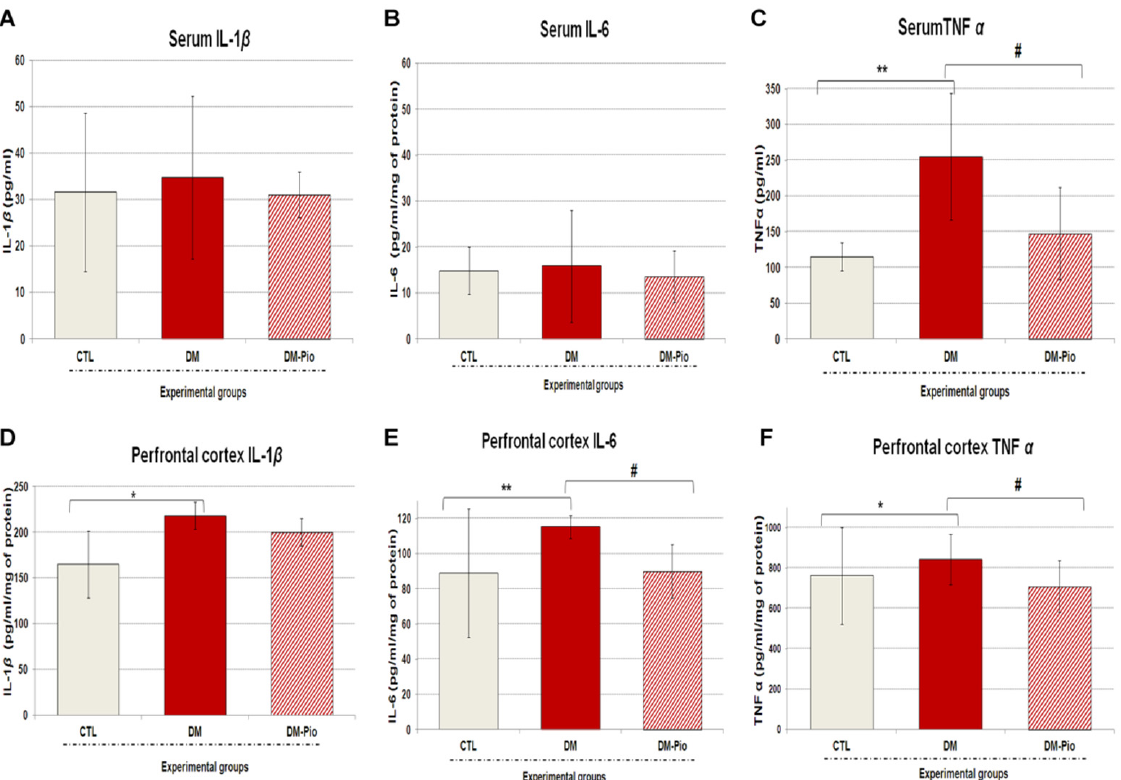
Figure 4. Influence of pioglitazone on inflammatory mediators in the blood serum or prefrontal cortex of diabetic mice. IL-1 β ( A ), IL-6 ( B ), and TNF α ( C ) were measured by ELISA kits in the serum of blood; IL-1 β ( D ), IL-6 ( E ), and TNF α ( F ) were measured by ELISA kits in the prefrontal cortex. All data were analyzed by one-way ANOVA, then Tukey’s post-hoc test for comparing differences between non-diabetic mice group (CTL), diabetic group (DM), and pioglitazone-treated group (DM-Pio) [30 mg /kg, po ]. All data have been presented as mean ± SD. * p < 0.05; ** p < 0.01 in comparison with control group. # p < 0.05 in comparison with diabetes group.